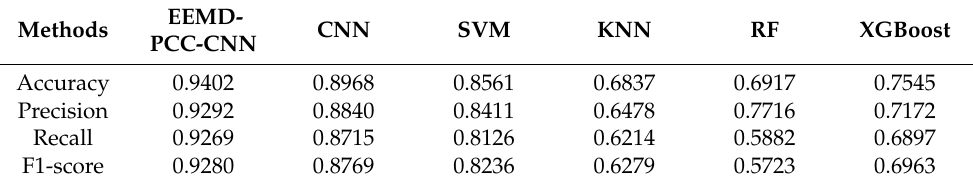
Table 5. Experimental results of EEMD-PCC-CNN on the three-story building